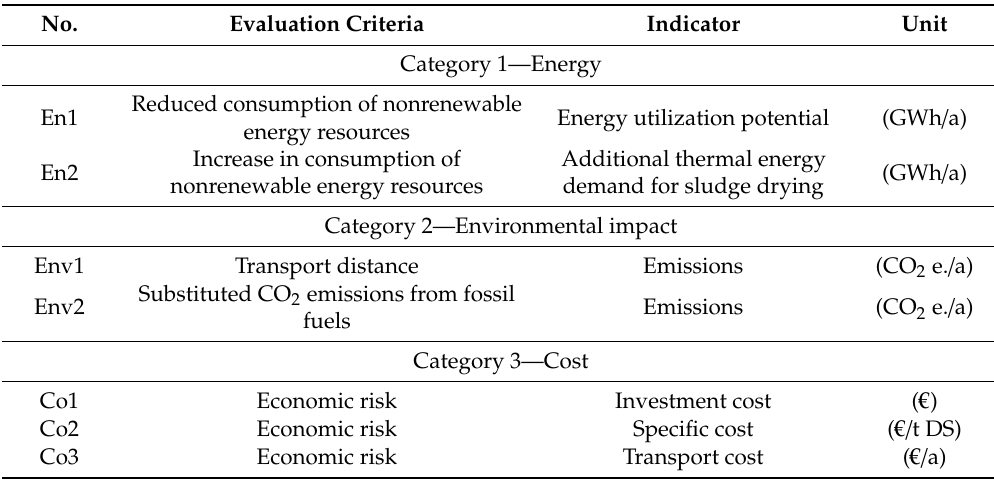
Table 6. Summary of evaluation criteria listed in the categories energy 1 (En1), energy 2 (En2), environment 1 (Env1), environment 2 (Env2), Cost 1 (Co1), Cost 2 (Co2), Cost 3 (Co3), and associated indicators with units used for the MCA.